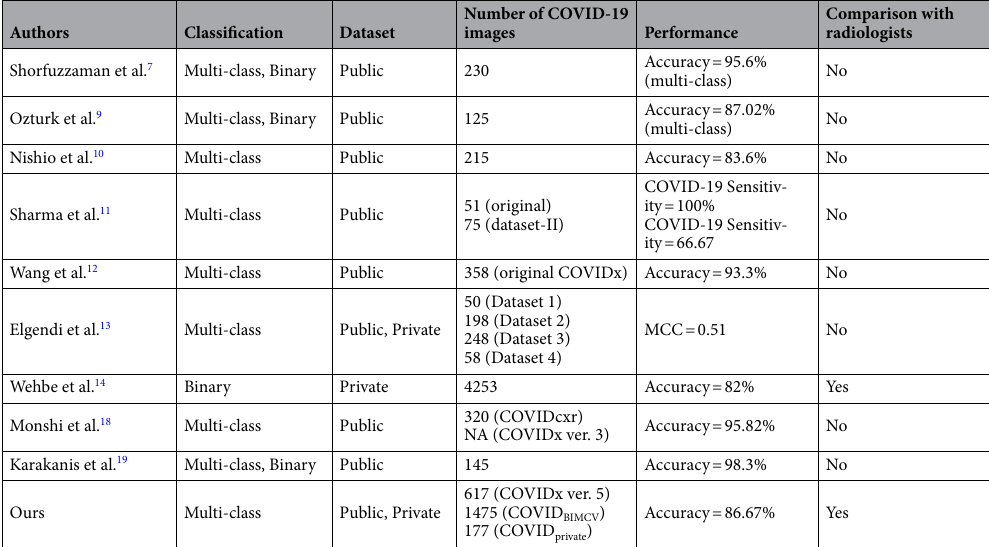
Table 5. Summary of COVID-19 DL models on CXR images. Definition of accuracy in multi-class classification may be different between these studies. CXR chest X-Ray imaging; DL deep learning; NA not available; MCC Matthews correlation coefficient; COVIDx public dataset used for